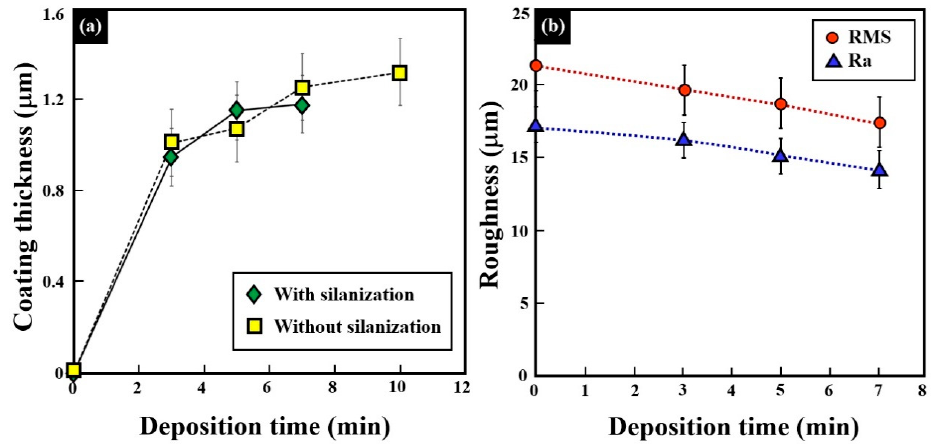
Figure 6. The laboratory-developed silver coating on top of AM-LPBF AlSi10Mg substrate: ( a ) film thickness as a function of deposition time with and without silanization; and ( b ) RMS and Ra surface roughness without silanization (measured by profilometer).